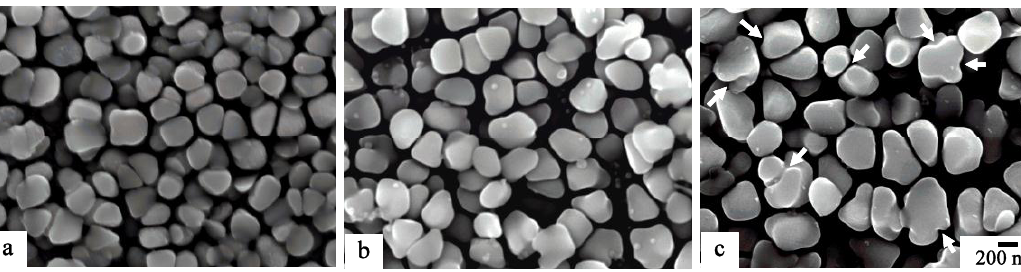
Figure 4. Morphological evolution of the secondary γ ′ precipitates after aging at 1123 K for 1 h ( a ), 4 h ( b ), and 8 h ( c ) in the D4 alloys. The precipitates tend towards irregular-shape morphology rather than a granular shape as the aging increased. The arrows in ( c ) indicates “dents” of the γ ′ particles.